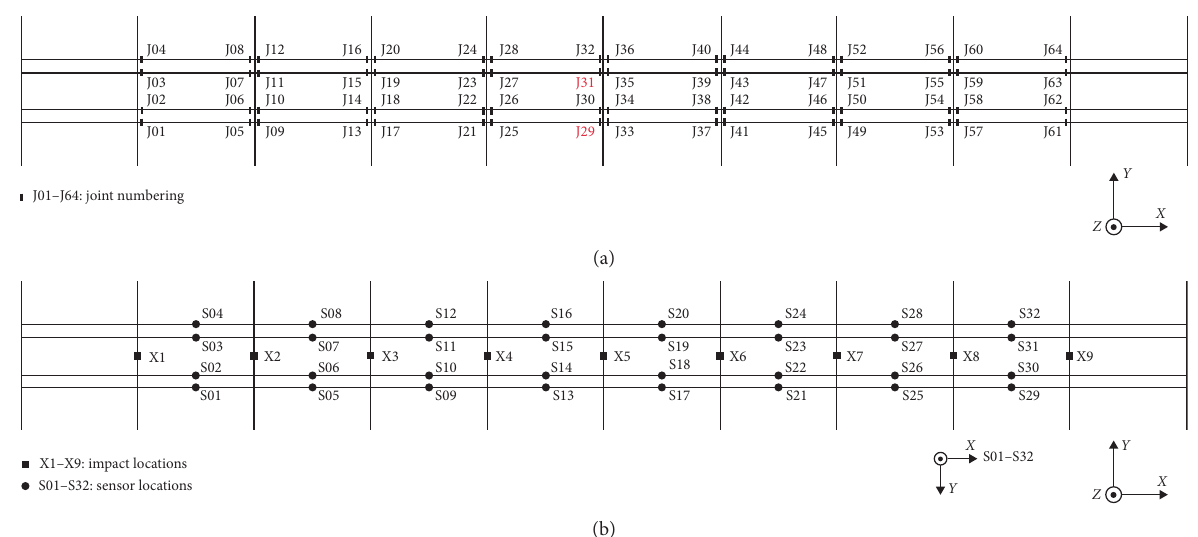
Figure 3: Instrumentation setup of the Hell Bridge Test Arena bridge deck (plan view). (a) Joint numbering with known damaged joints highlighted in red. (b) Sensor and impact